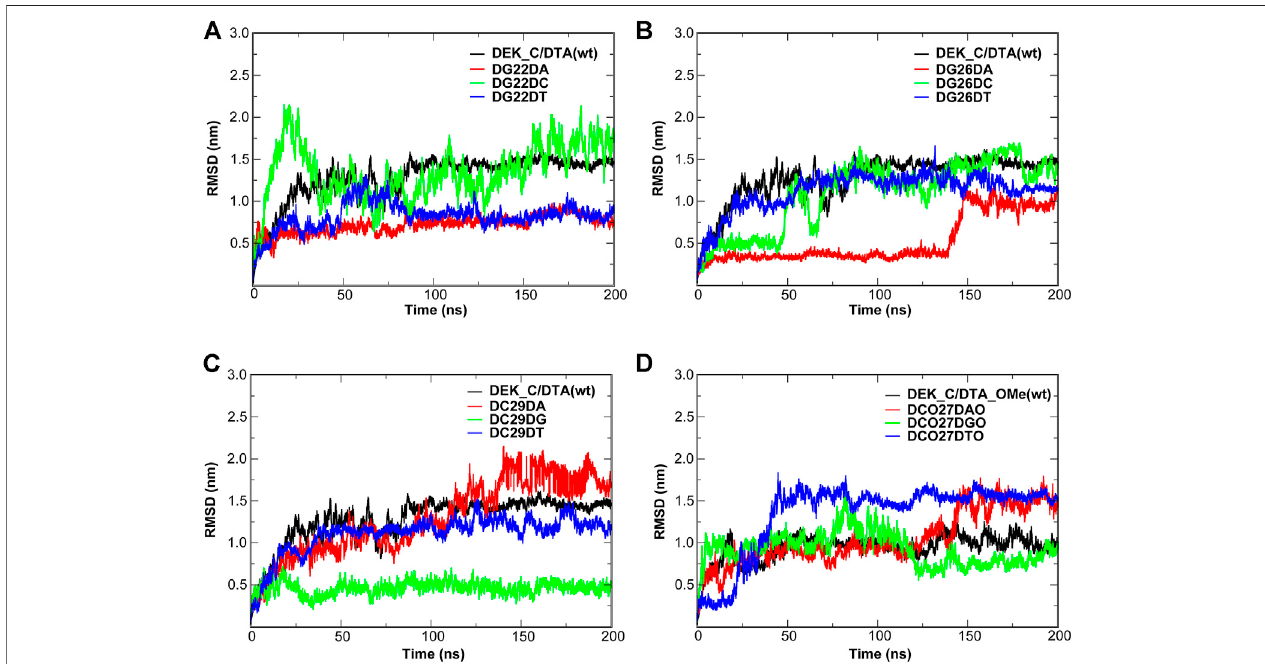
FIGURE11| RMSDofthewildtypecomplexesandthecorrespondingmutants. (A – C) DEK_C/DTAcomplexanditsmutants. (D) DEK_C/DTA_OMecomplexand its mutants.